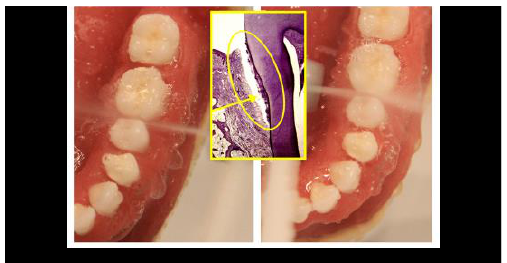
Figure 6. Oral irrigators in action, in order to remove sub-gingival biofilm.